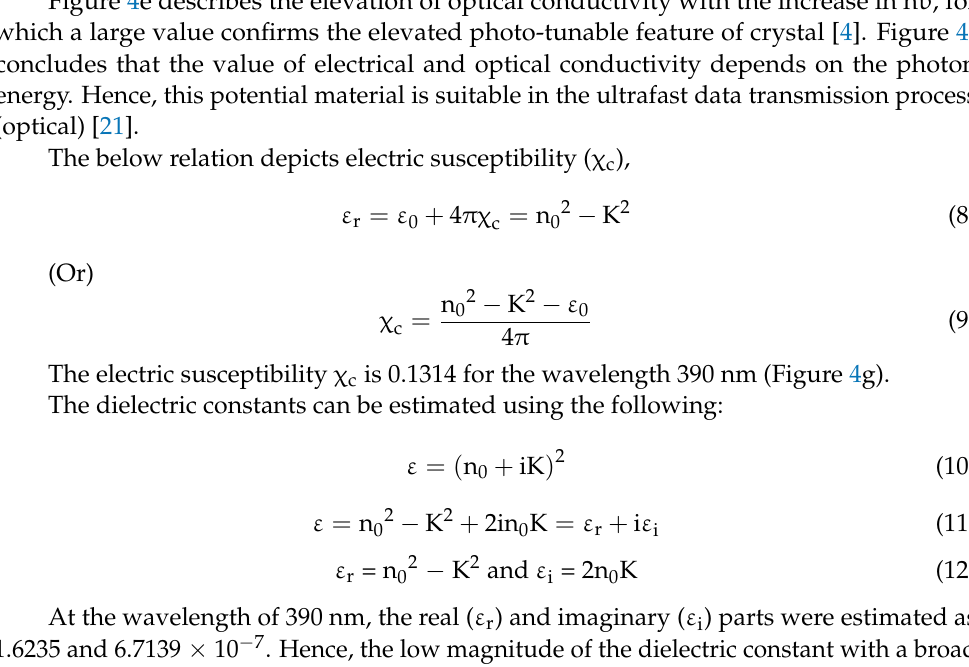
Figure 5. Plot ln(α) vs. hυ for LPPMA .